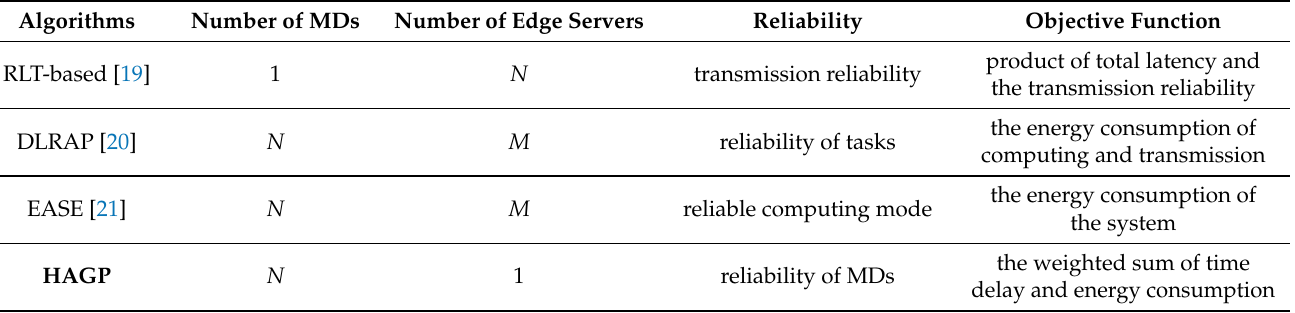
Table 3. Differences between several